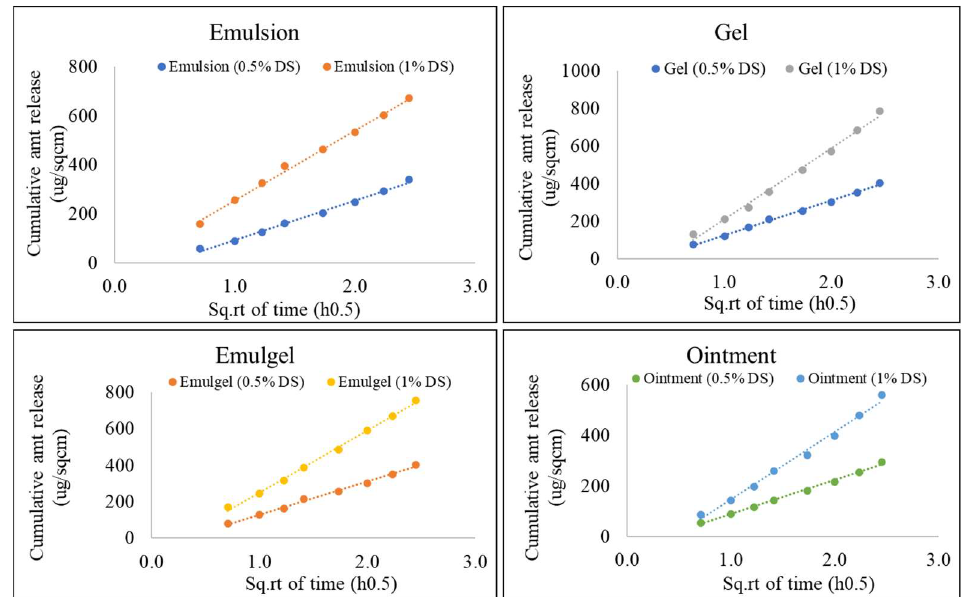
Figure 5. Effect of dosage strength on release rate for all formulations. Data shown are mean of six replicates.